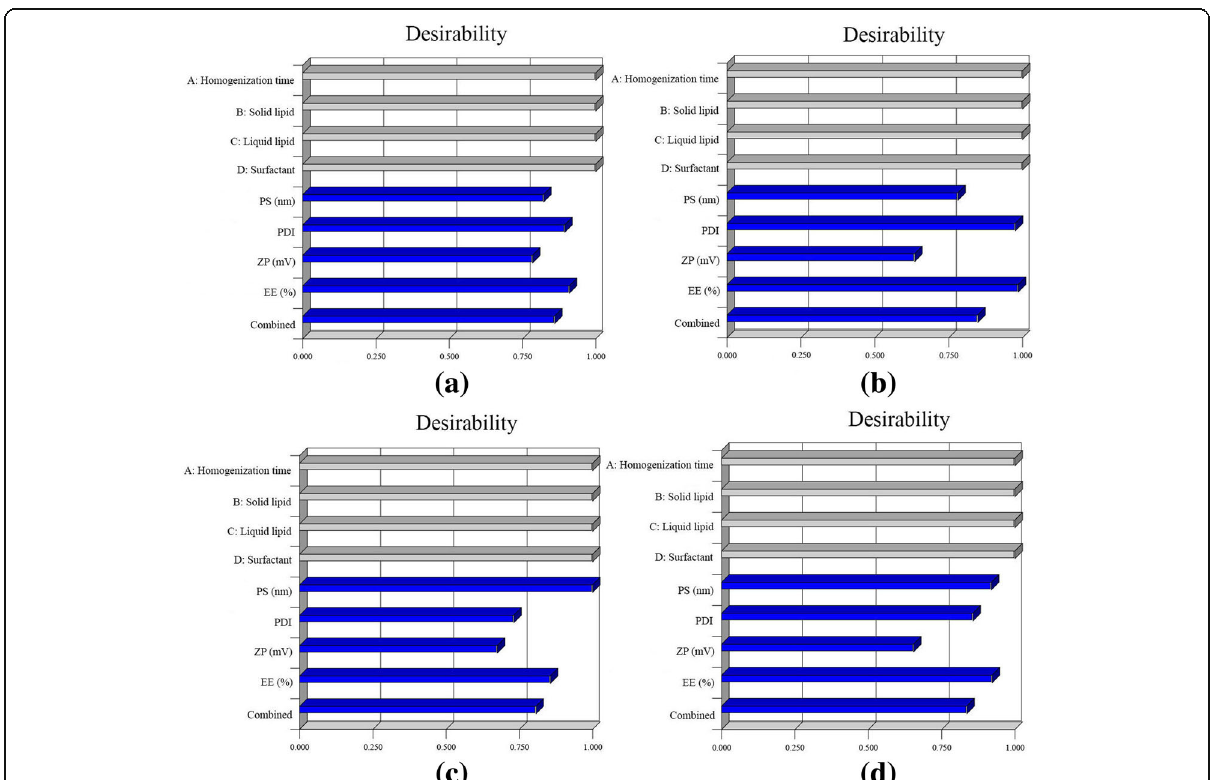
Fig. 6 Bar graph displaying the individual and combined desirability of several responses on selected HVD-NLCs formulations. a VER-9, b VER-11, c VER-13, and d